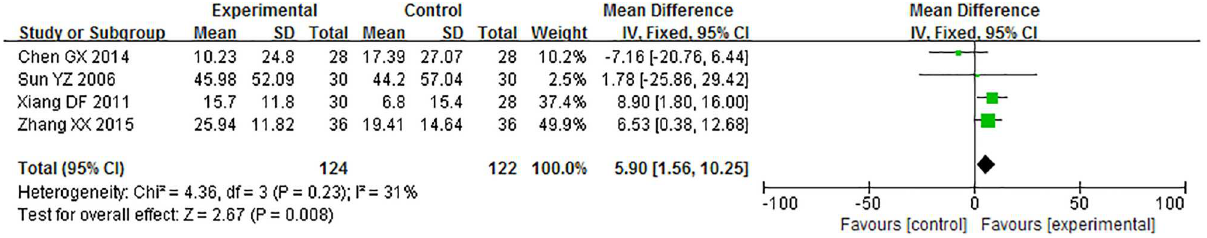
Fig 5. Meta-analysis of the variation in peripheral blood CA-125